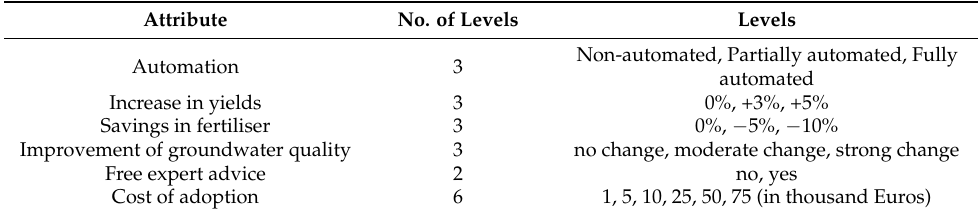
Table 2. Attributes of the proposed options and description of different levels. Attribute No. of